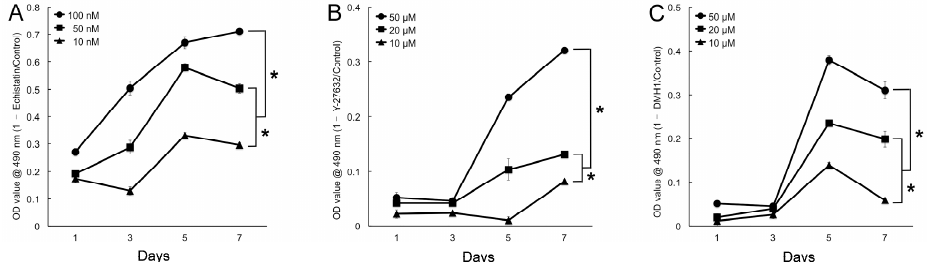
Figure 2. Effects of mechanotransduction inhibitors on cell proliferation. All inhibitors concentrations decreased cell proliferation at all time points compared to controls. After seven days, the proliferation decreased by approximately 30%, when cells were treated with 10 nM of echistatin ( A ) and 50 µM of Y27632 and DMH1 ( B , C ) comparing to the untreated control. (* denotes statistical difference between the groups, p < 0.05. For the sake of clarity, only the statistical significances at day seven are depicted).